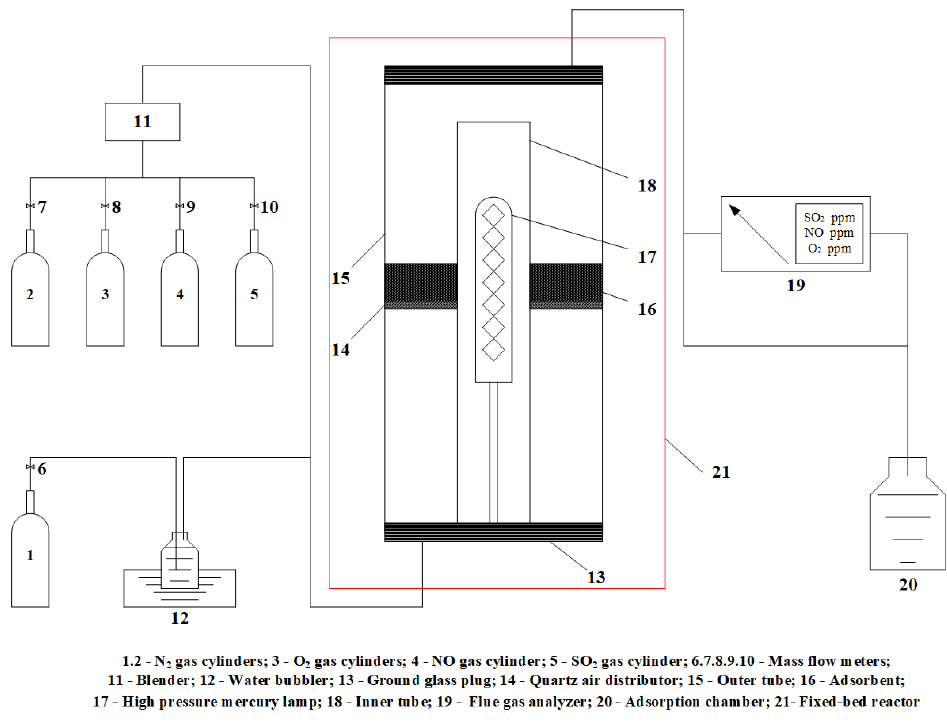
Figure 1. The schematic of the experimental system. The O 2 , NO, SO 2 , and N 2 in the simulated flue gas were supplied by gas cylinders (Dalian Special Gas Company, China), and the flow rates were adjusted by mass flowmeters (CS200-A) supplied by the Sevenstar Flow Company. H 2 O was produced by a water bubbler and brought into the fixed-bed reactor by N 2 . The total flow rate of the simulated flue gas was maintained at 1 L/min during all the